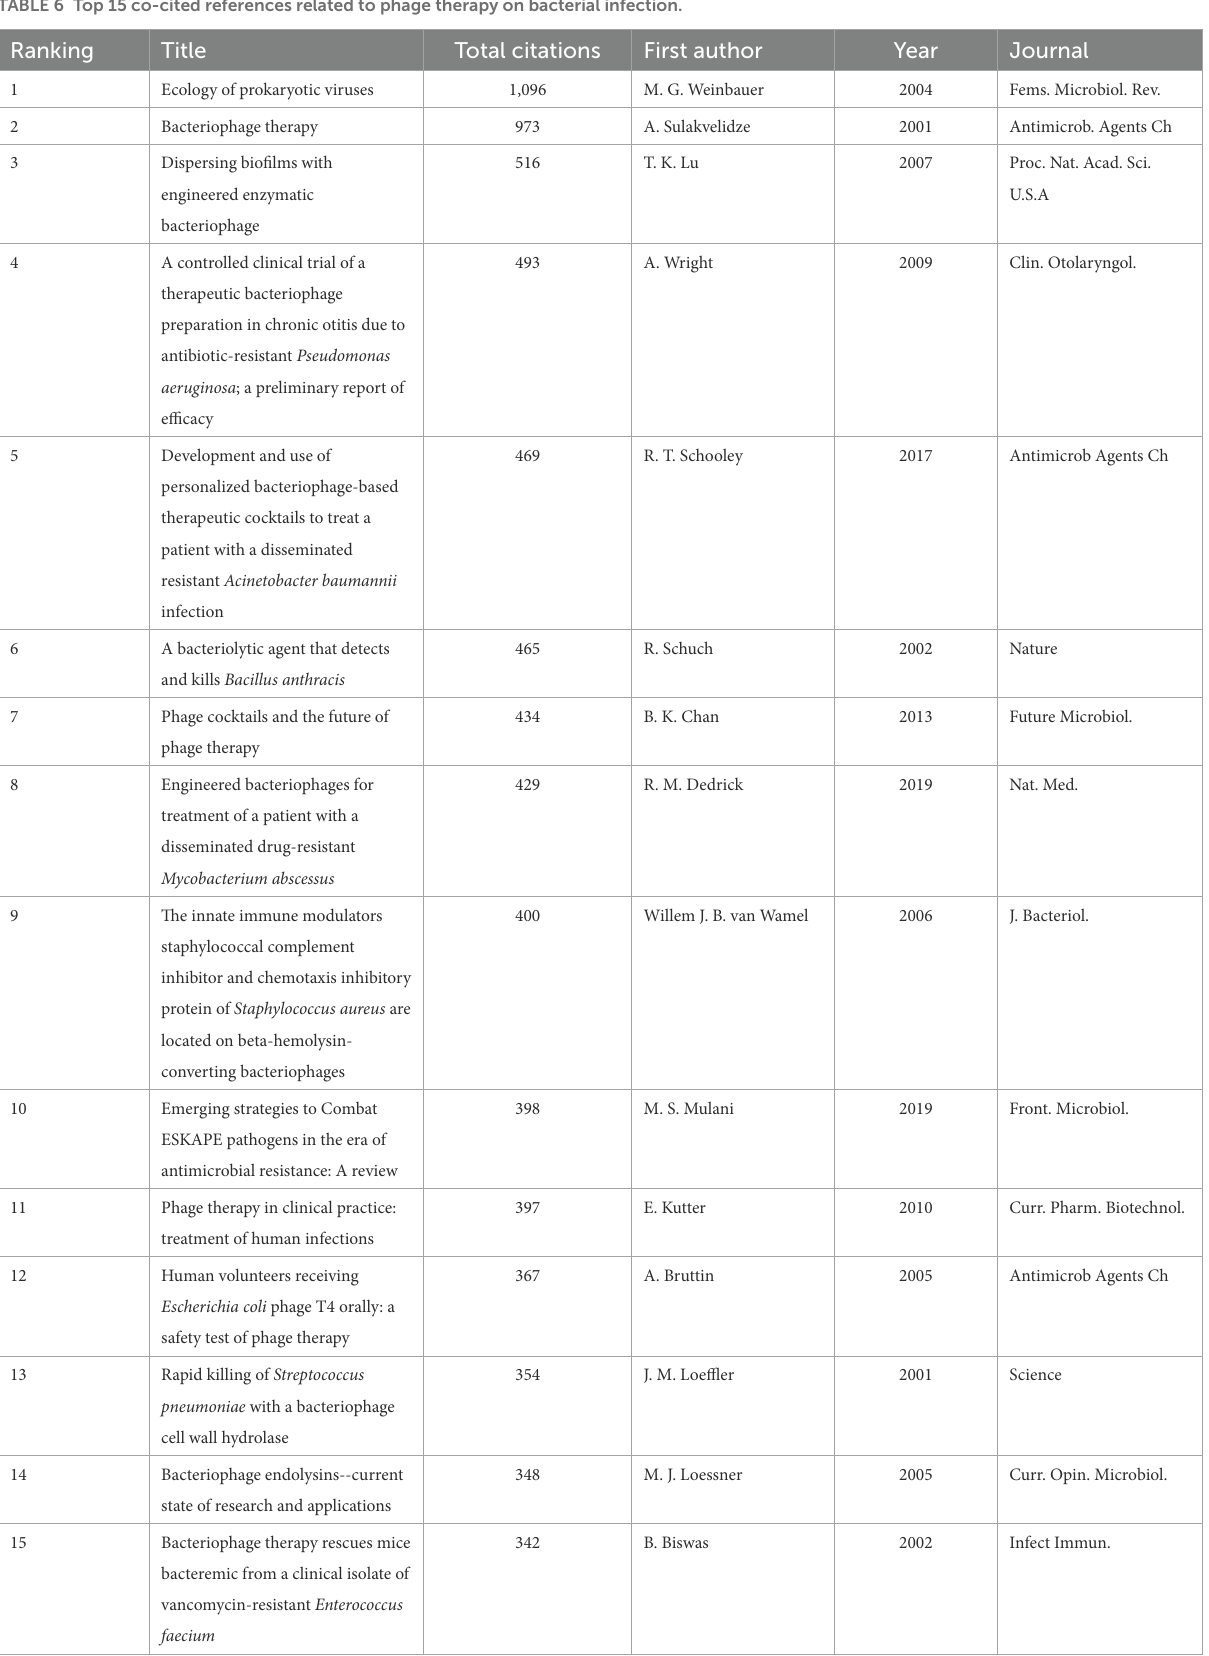
TABLE 6 Top 15 co-cited references related to phage therapy on bacterial